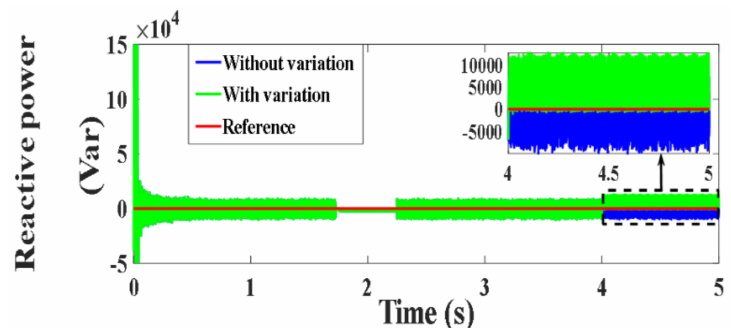
Figure 152. Reactive power under PVC (var).